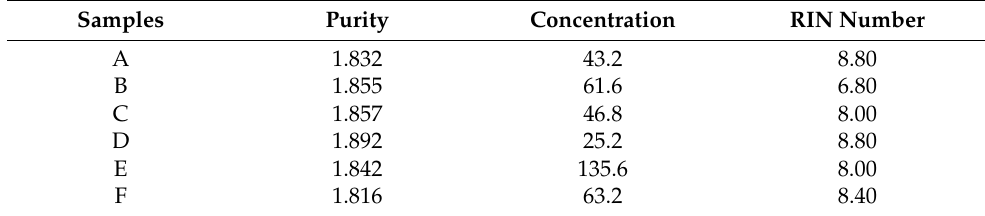
Table 2. Purity, concentration, and integrity of RNA